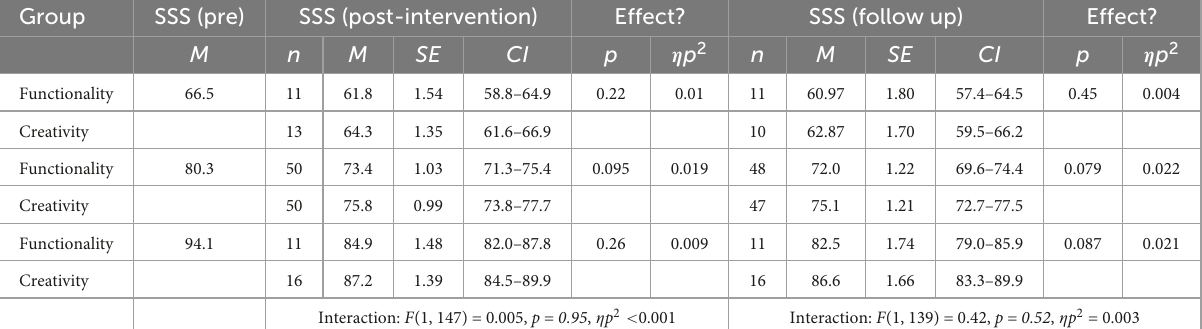
TABLE 8 Summary of completer analysis for skin shame (SSS), including estimated marginal means and effects of the intervention at baseline values of SSS one-standard deviation below the mean, the mean, and one-standard deviation above the mean, as well as the interaction effect (baseline SSS and study arm) on SSS at post-intervention ( n = 151) and 1-month follow up ( n = 143). Group SSS